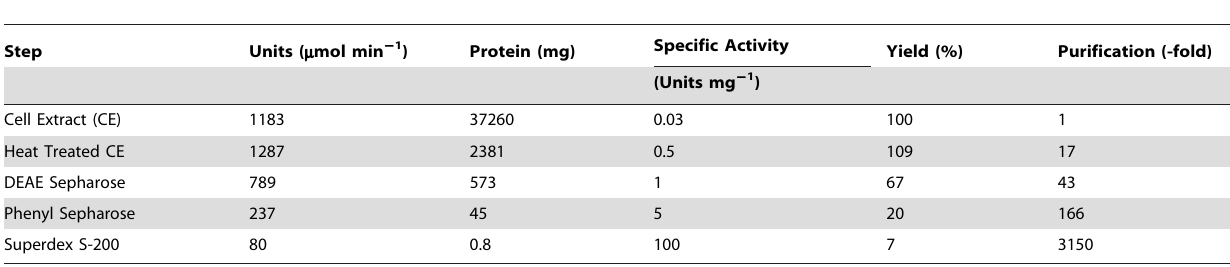
Table 2. Purification of recombinant P. furiosus SHI from E. coli .